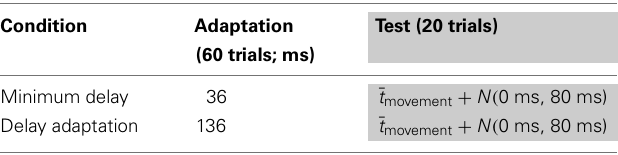
Table 2 |Actual feedback delays used for the minimum delay, physical delay, delay adapted, and subjective delay